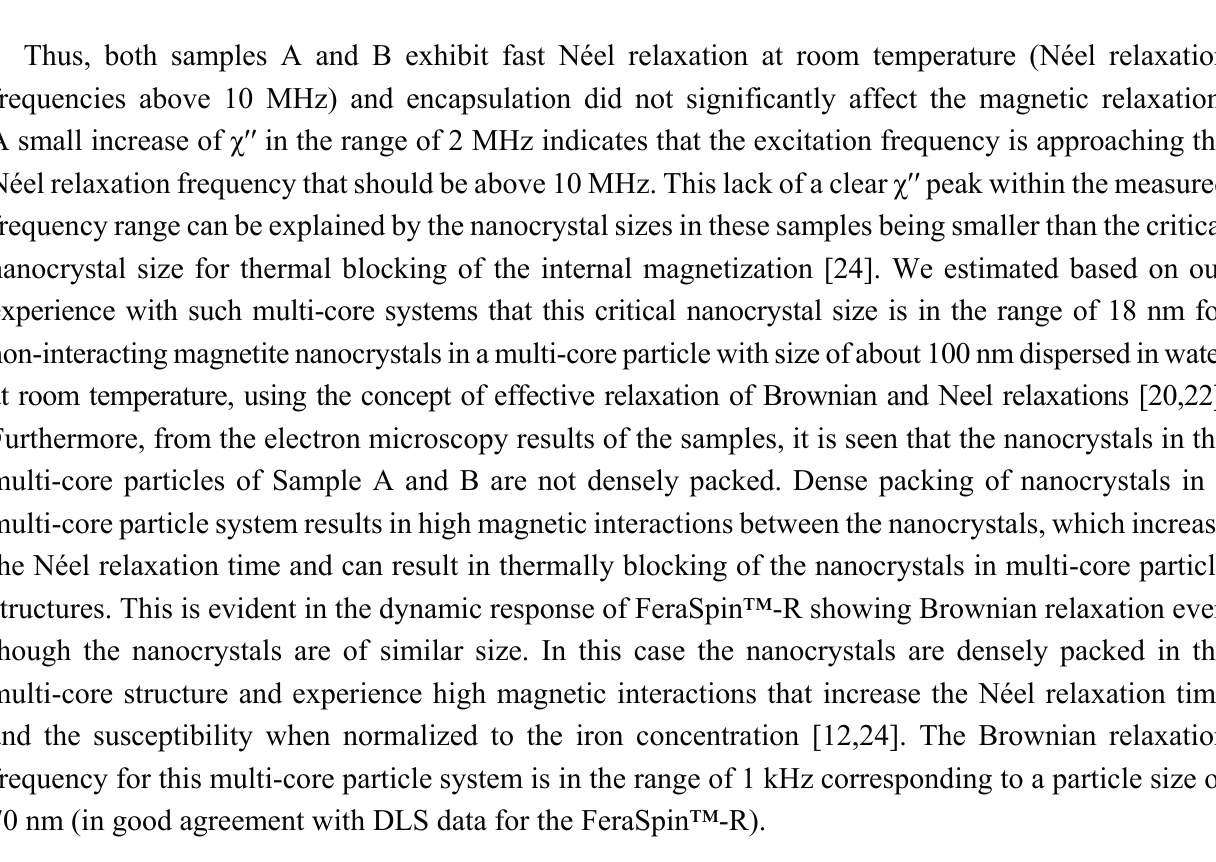
Figure 9. Real and imaginary components of the AC susceptibility versus frequency of samples A and B (left y-scale), and FeraSpin™-R (right y-scale) at room temperature. No magnetic relaxation peak is observed for samples A and B. As a comparison, a commercial multi-core sample, FeraSpin™-R from nanoPET (right scale), shows a well-developed relaxation peak, indicating a Brownian relaxation frequency in the range of 1